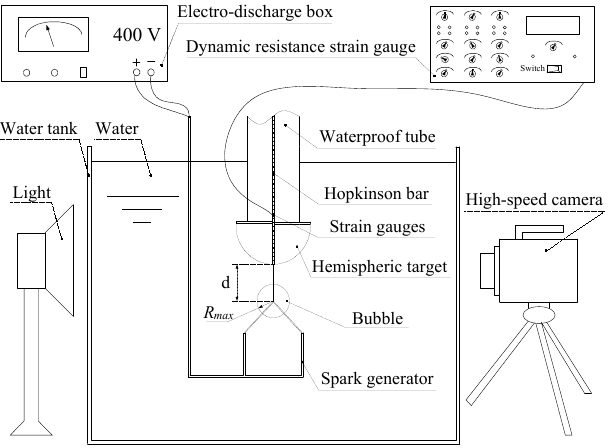
Figure 6. Schematic diagram of the experimental arrangement.